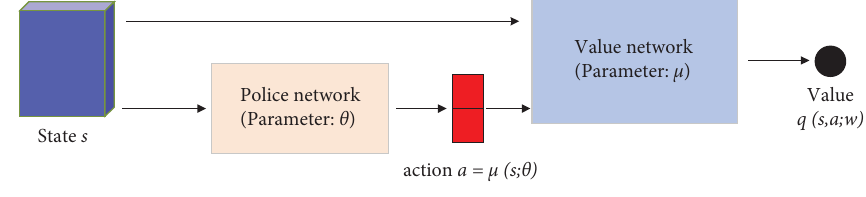
Figure 7: Diagram of DDPG.